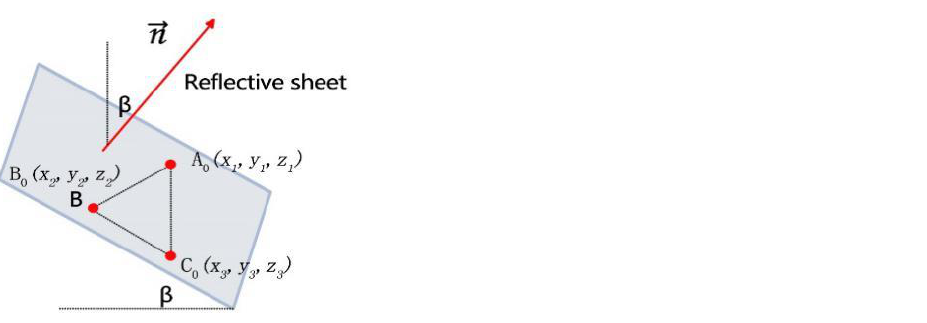
Figure 6. Schematic diagram of the deflection measurement of the laser monitoring equipment.